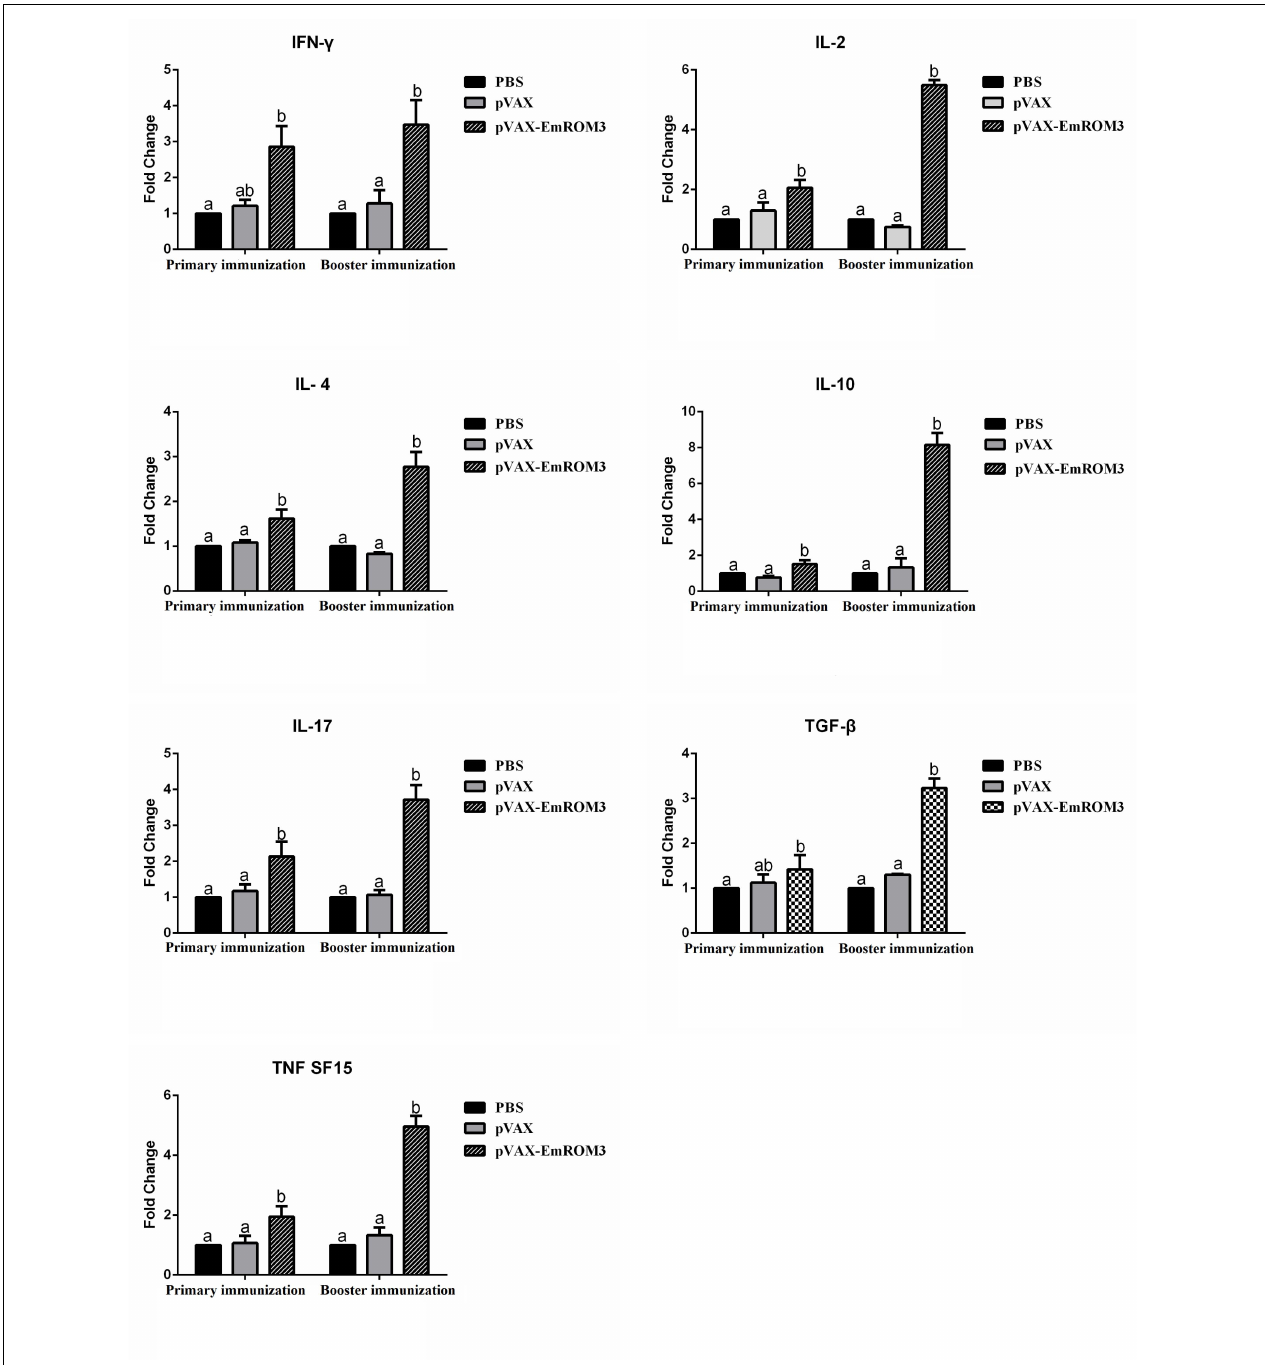
FIGURE 7 | Transcript level of cytokine gene in sera from chickens immunized with plasmid pVAX-EmROM3. N = 5, the error bars = standard deviation. Significant difference ( P < 0 . 05) between groups is marked with different letters. No significant difference ( P > 0 . 05) between groups is marked with the same letter.